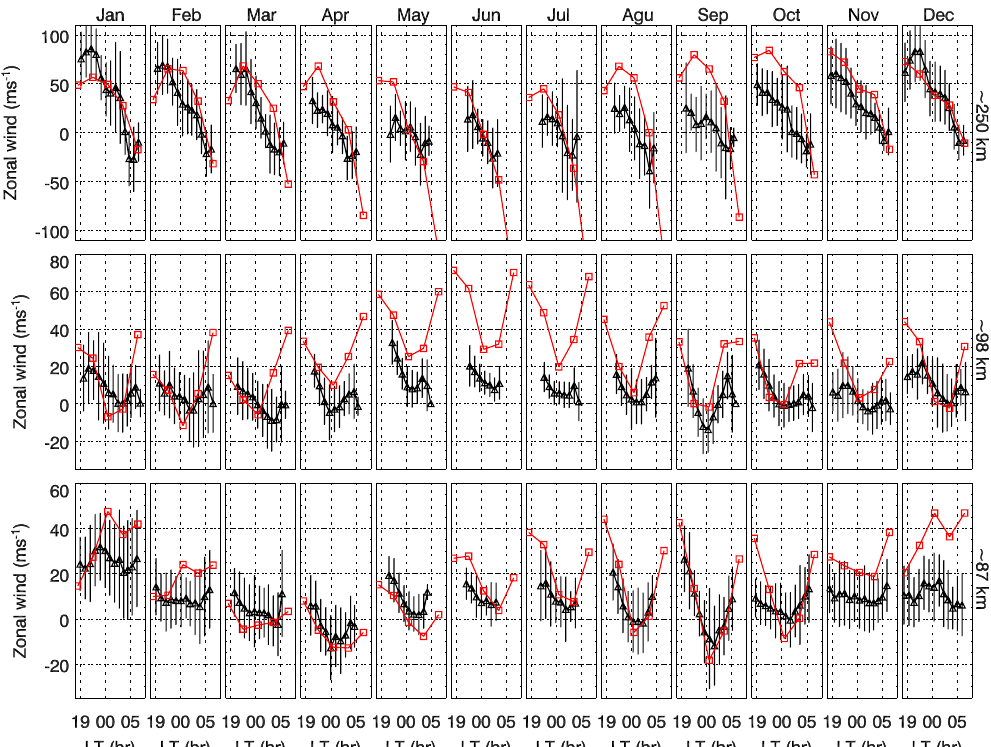
Fig. 7. Same as Fig. 6 but for the monthly average (eastward